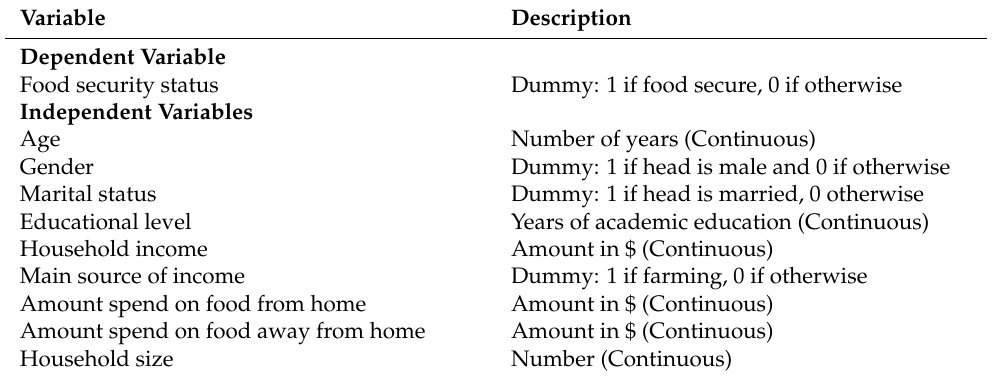
Table 3. Variable descriptions for factors affecting food security status of the